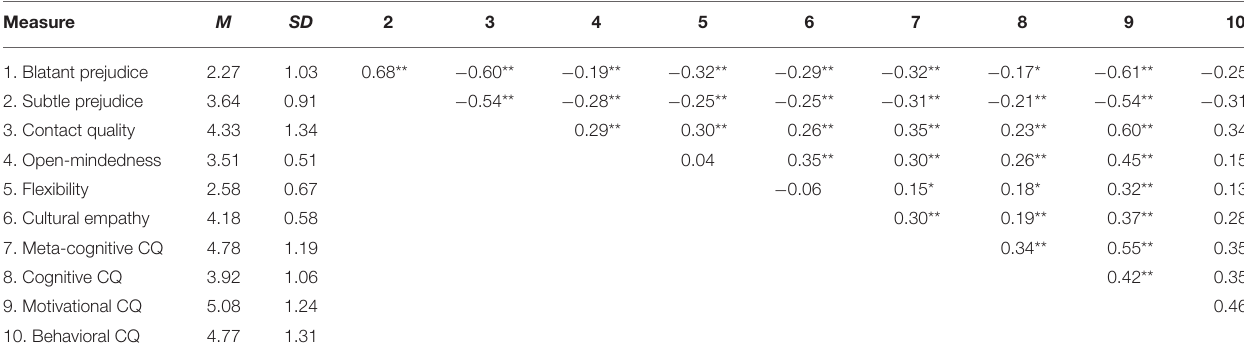
TABLE 4E | German sample II: means, standard deviations, and intercorrelations for the main variables. Measure